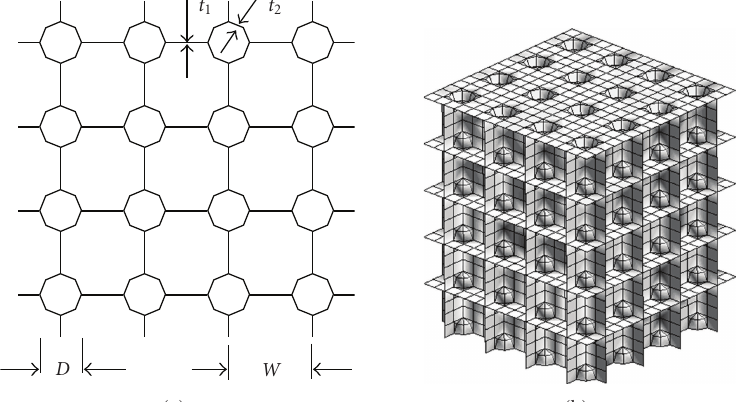
Figure 6: (a) Schematic diagram of the weaker cruciform-stronger-hemisphere model (a) top view (cell morphology), and (b) isometric view of a complete model.